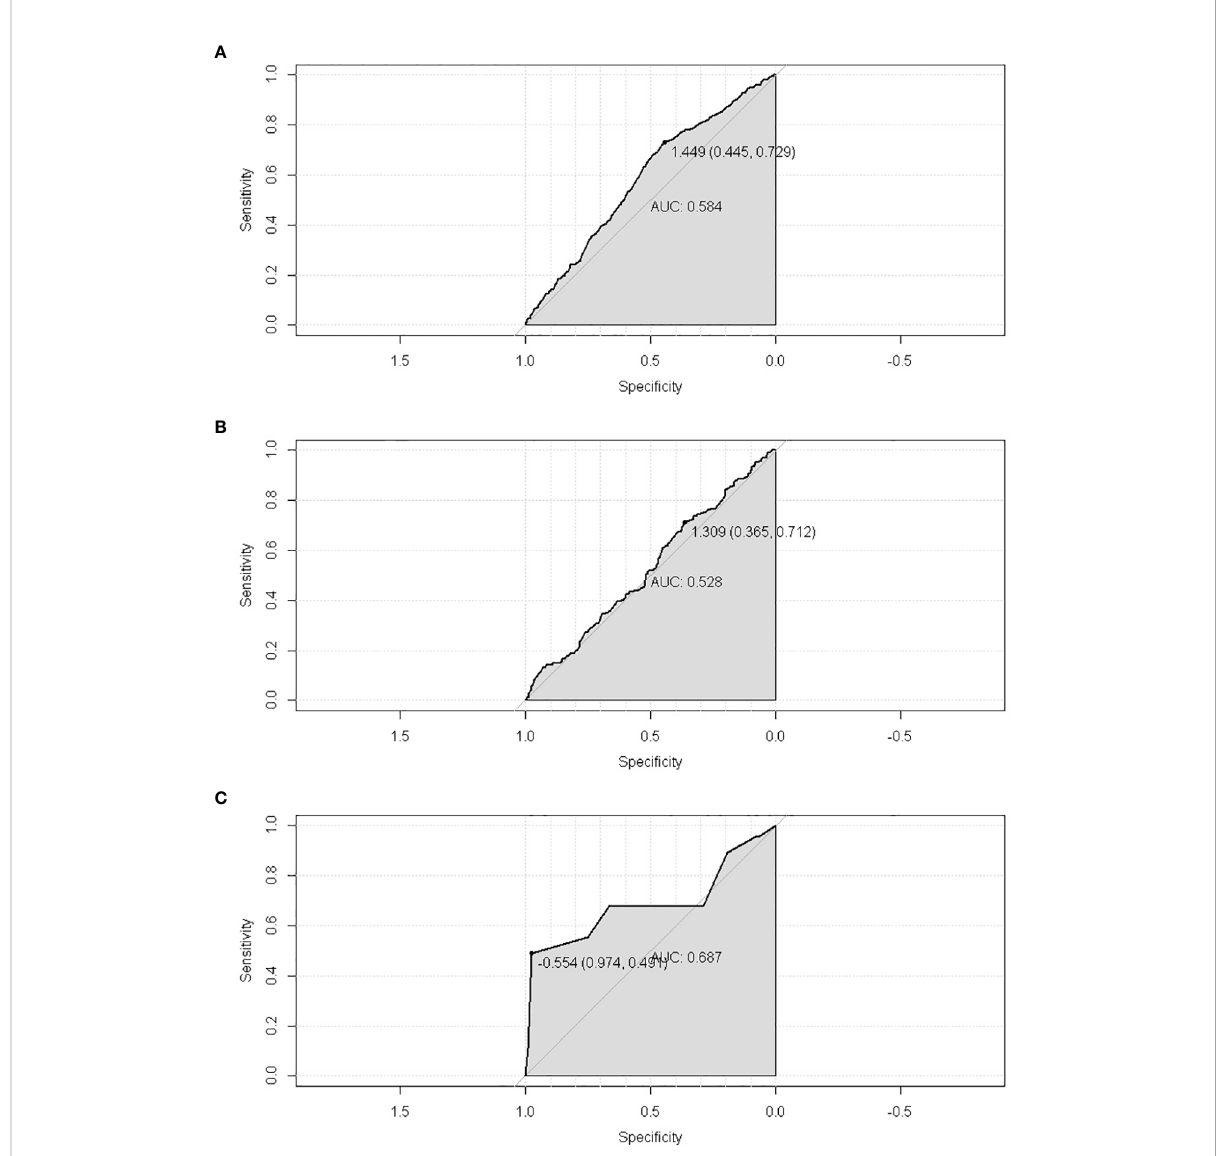
FIGURE 11 The ROC of the nomogram of predicting the latency between cervical cancer and SPM. (A) trainset; (B) testset; (C) external test